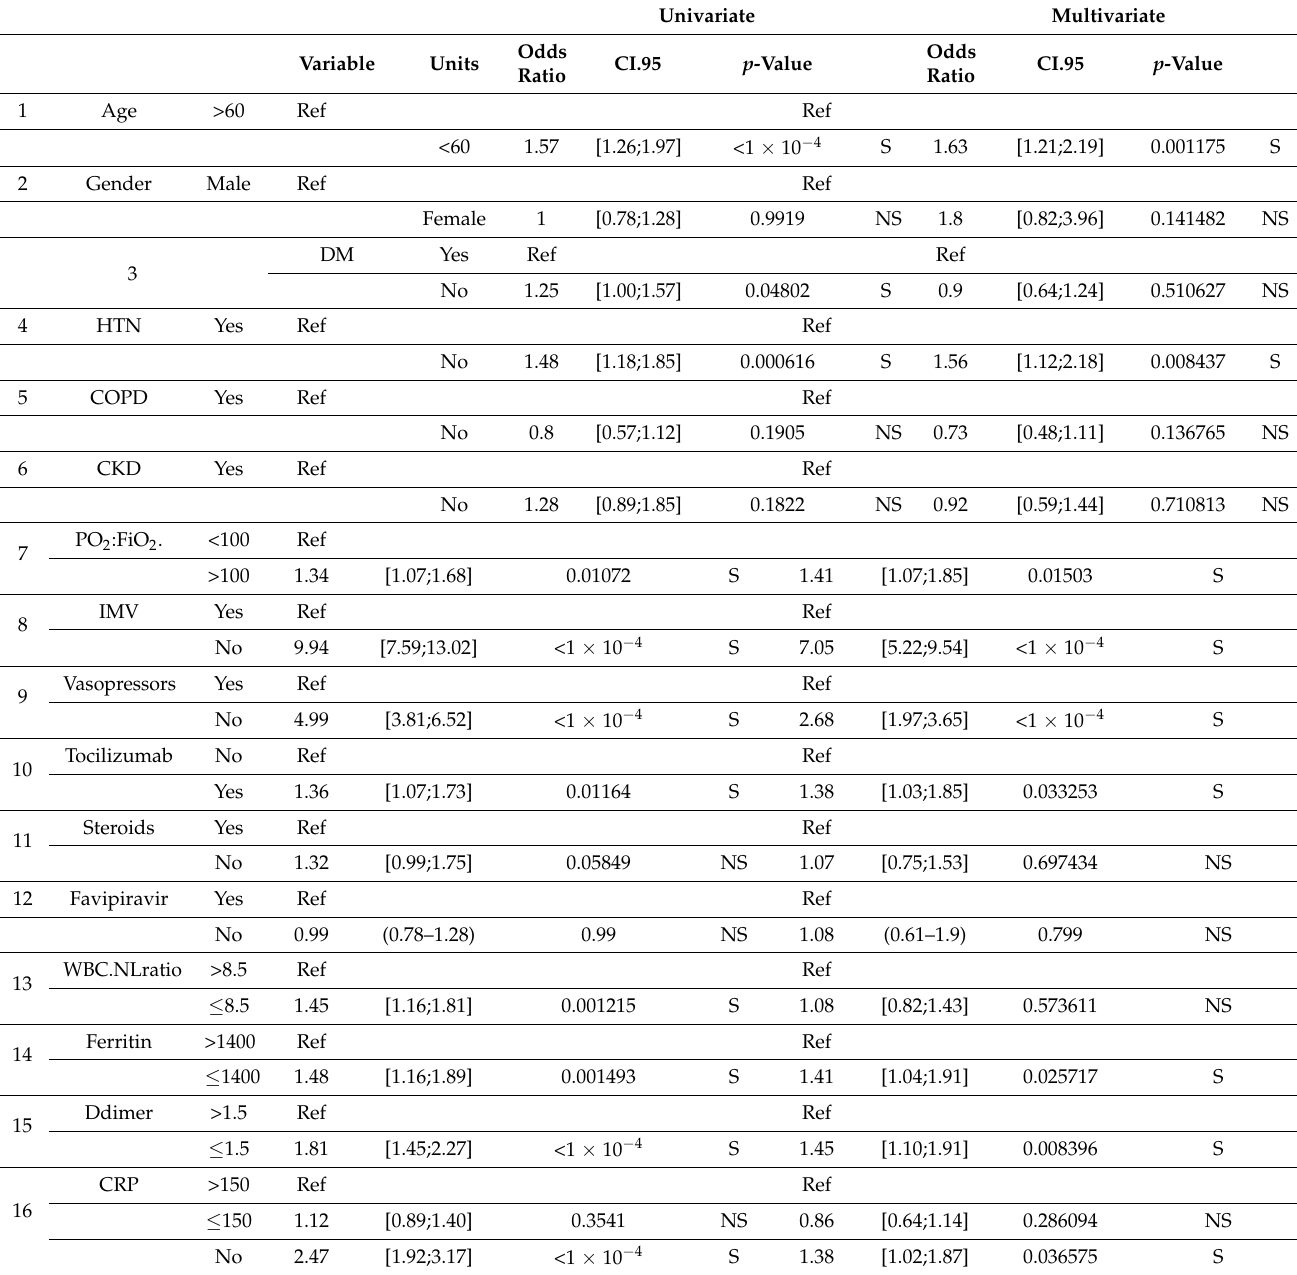
Table 3. Multivariate logistic regression for the overall 28 day hospital survival in the fully propensity- matched